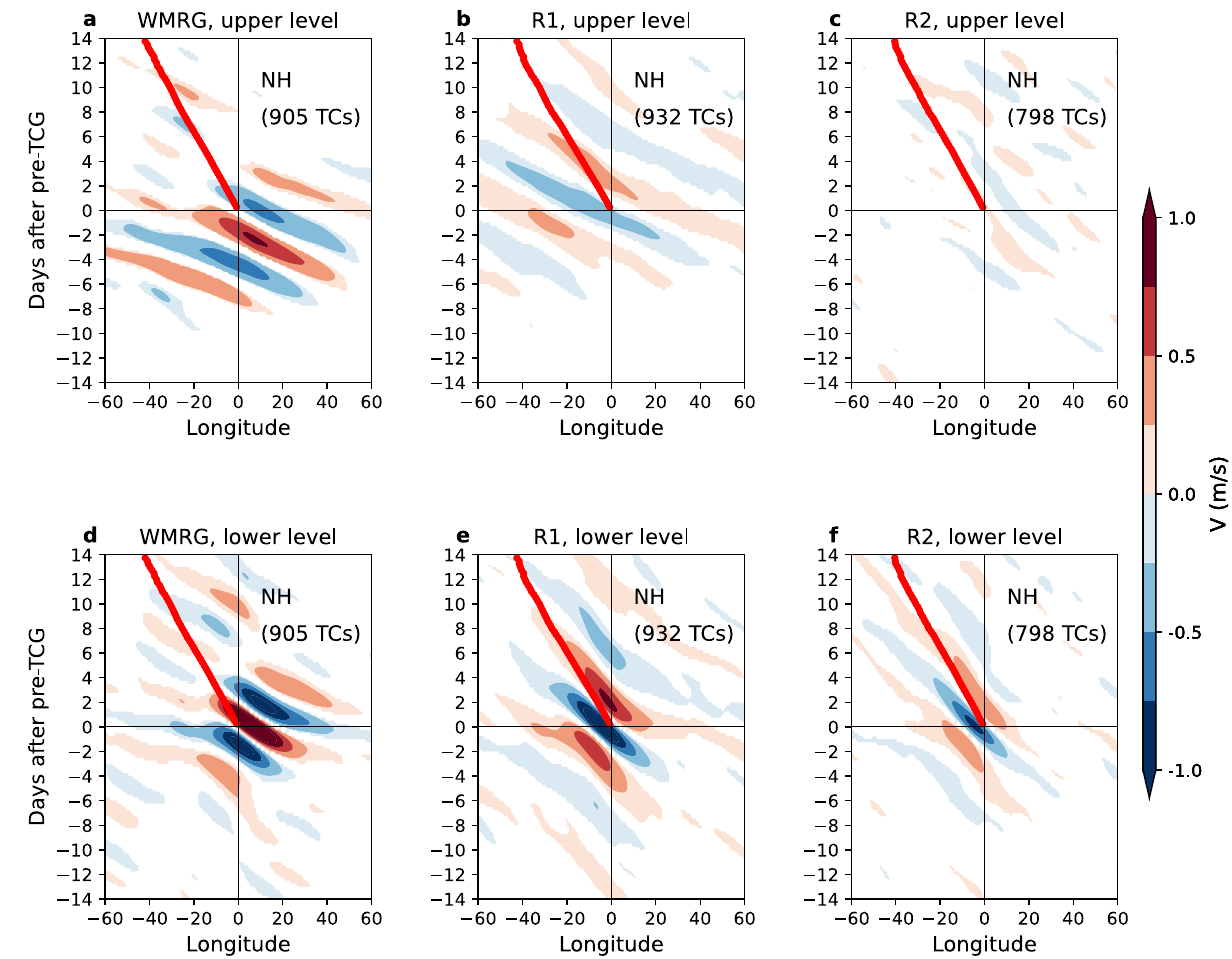
Fig. 3 | Hovmöller diagram of equatorial waves onto pre-tropical cyclogenesis (pre-TCG) events in the Northern Hemisphere (NH). a Hovmöller diagram of composite means (shading) of Westward-moving Mixed Rossby-Gravity wave (WMRG) meridional winds ( V ) at the equator (0°N) in the upper troposphere onto pre-TCG events that are matched in-phase to the waves, with respect to the vortex longitude and event time of pre-TCG, in the NH. Only composite signi fi cant at the 95% con fi dence level is shown. The total number of pre-TCG events matched in- phase to each type of wave is provided in the top right; thick red line shows the